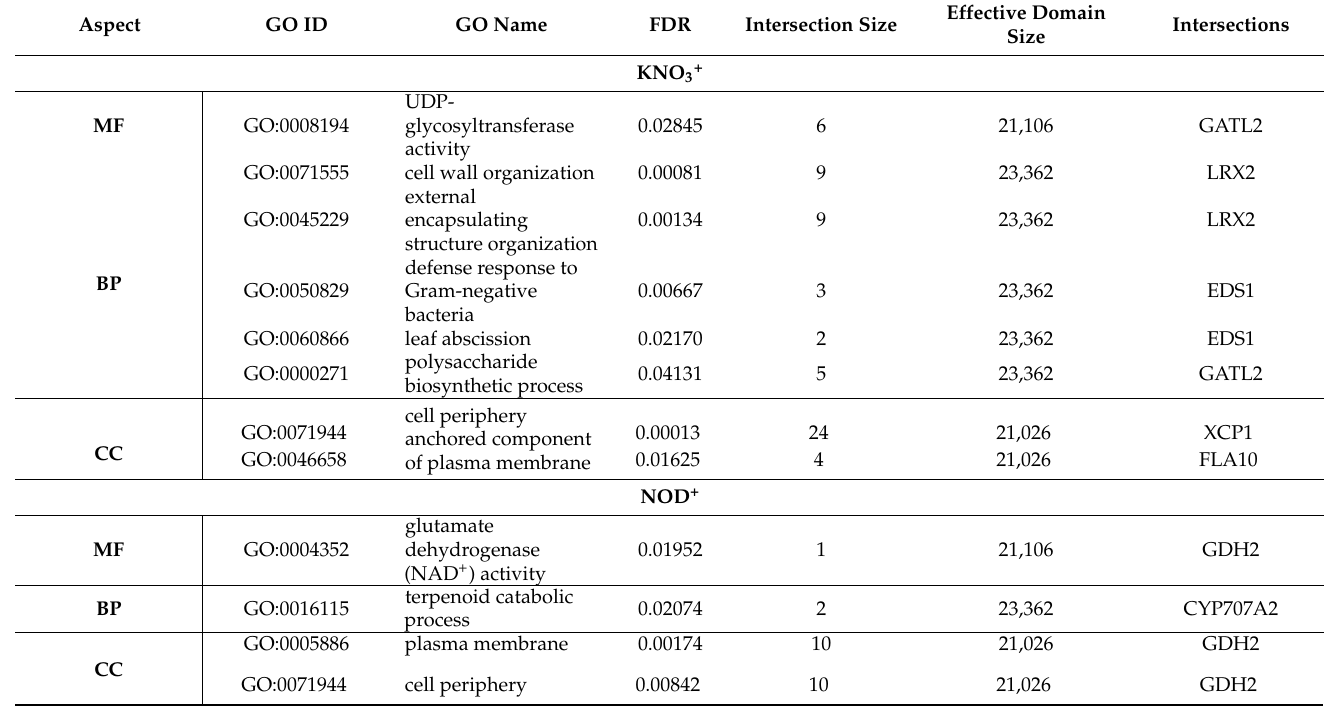
Table 6. Significantly enriched Gene Ontology (GO) terms, identified by Gene Set Enrichment Analysis (GSEA) of downregulated differentially expressed genes (DEGs) in non-nodulated Casuarina glauca plants supplied with KNO 3 (KNO 3+ ) or nodulated by nitrogen-fixing Frankia casuarinae Thr (NOD + ), grown at 400 mM NaCl, relative to control (0 mM NaCl). GO aspect, GO ID, GO Name, False Discovery Rate (FDR), intersection size, effective domain size and main gene intersections were retrieved from g:GOSt functional profiling of the gProfiler website, within a threshold of FDR <